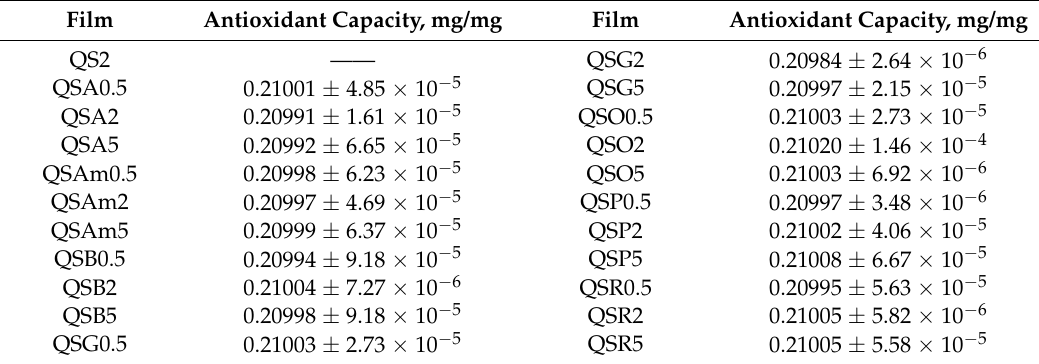
Figure 7. Calibration curve of gallic acid. Table 4. Antioxidant capacity of each film (mg/mg equivalent to gallic